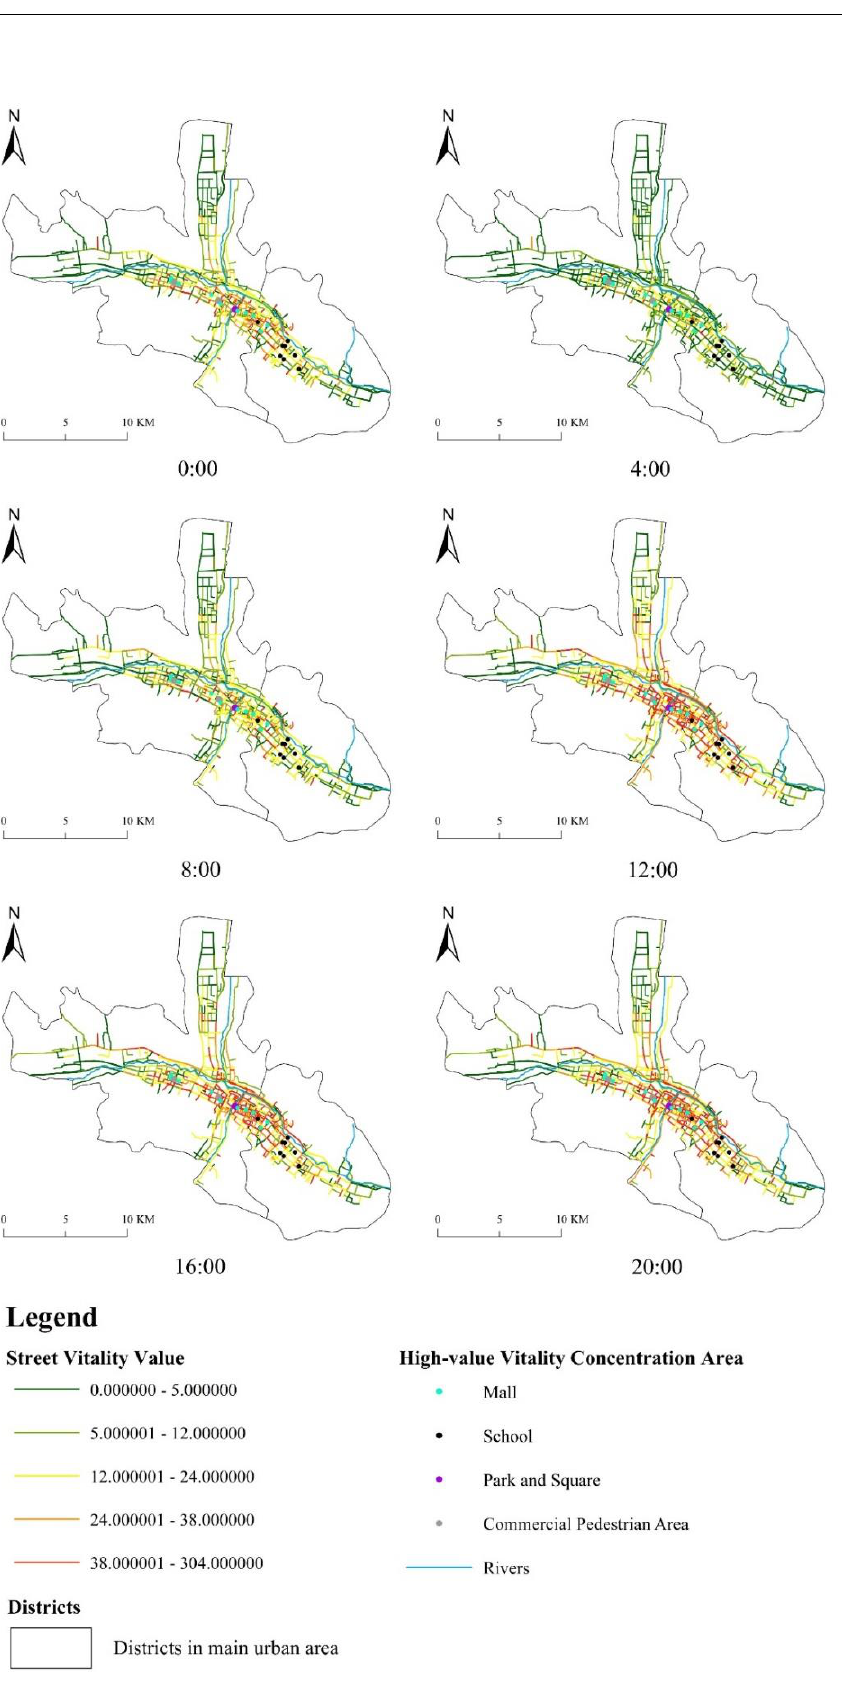
Figure 4. Spatio–temporal vitality of streets.